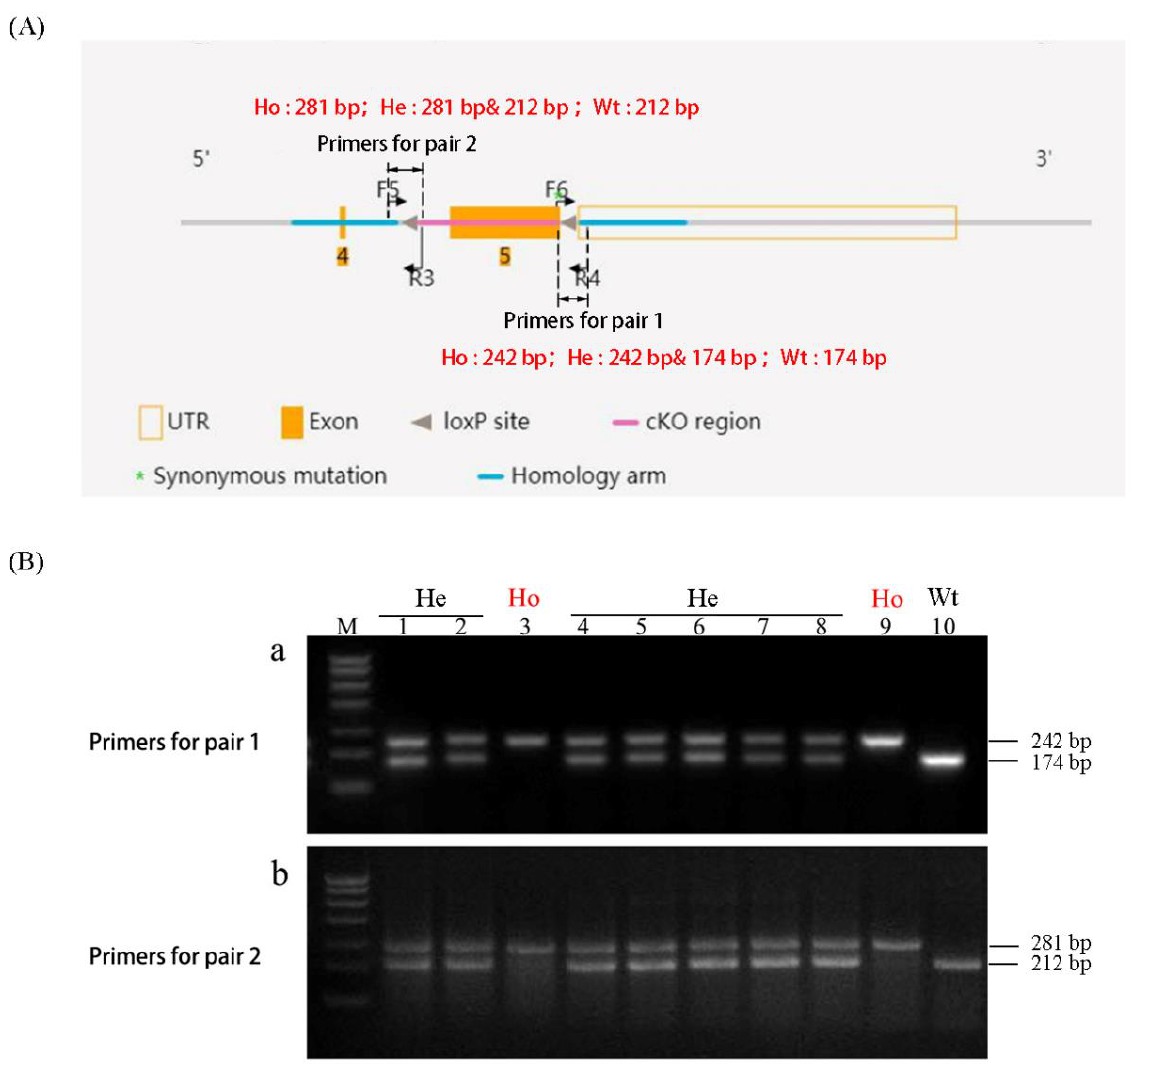
Figure 4. Identification of homozygous Rlim fl/fl and heterozygous Rlim fl/+ transgenic female mice. ( A ) Schematic diagram of primer locations for PCR identification of homozygous Rlim fl/fl and heterozygous Rlim fl/+ transgenic female mice. The PCR products of primer pair 1 (F6 and R4) for homozygous transgenic, heterozygous transgenic, wild-type mice are 242 bp (contains the right loxP site), 242 bp and 174 pb, 174 bp (no loxP site) in length, respectively. The PCR products of primer pair 2 (F5 and R3) for homozygous transgenic, heterozygous transgenic, and wild-type mice are 282 bp (contains the left loxP site), 282 bp and 212 bp, 212 bp (no loxP site) in length, respectively. ( B ) PCR identification results of transgenic female mice. Ho represents homozygotes; He represents heterozygotes; Wt. represents wild